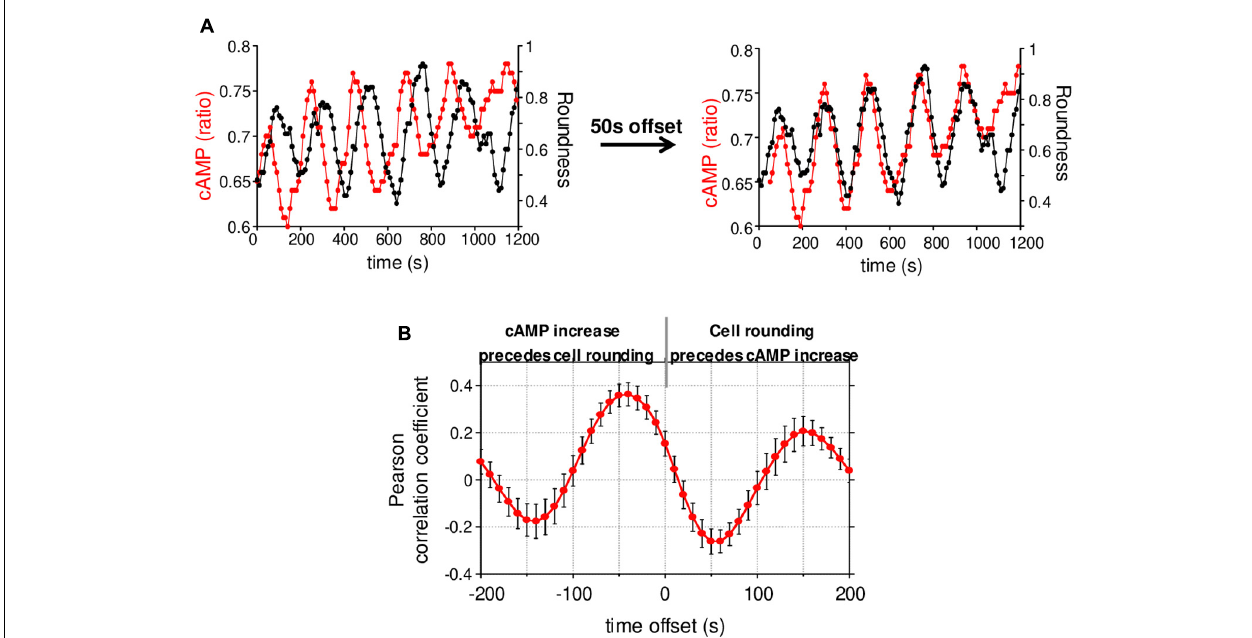
FIGURE 4 | cAMP variations and cell roundness. (A) Example of cAMP variations measured simultaneously with the cell roundness for the cell presented in Figure 3D . The shift of cAMP curve by 50 s allowed us to synchronize it with the cell roundness curve. (B) Cross-correlation between cAMP and cell roundness. A negative offset means cAMP increase precedes the cell rounding. Values correspond to the mean ± SE of cross-correlation coefficients measured on 17 cells displaying cAMP